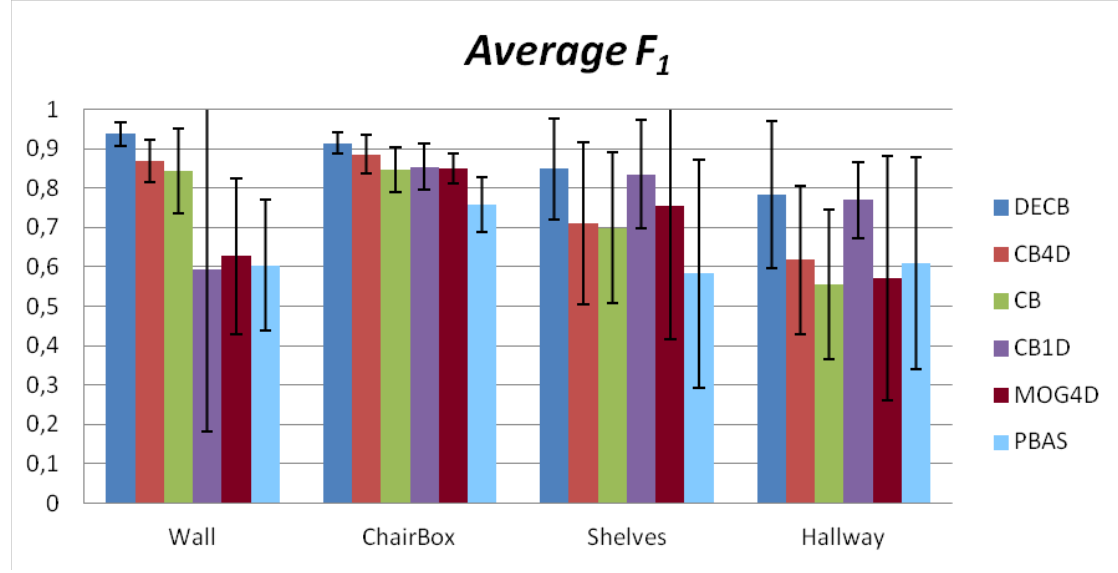
Figure 10. Average F obtained from the entire benchmark, including error bars showing 1 the standard deviation (along each benchmark